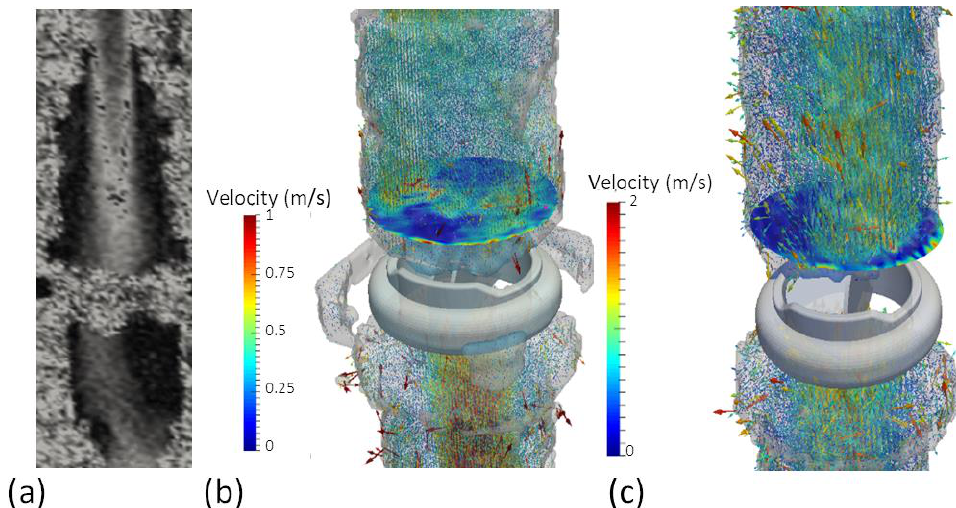
Figure 3. BMHV malfunction with MRI blurring around the BMHV ( a ), MRI 4D Phase-Contrast Acquisition with a superposed representation of normal functioning BMHV ( b ), and leaflet blocked MBHV ( c ) with AST values on the surface plane.